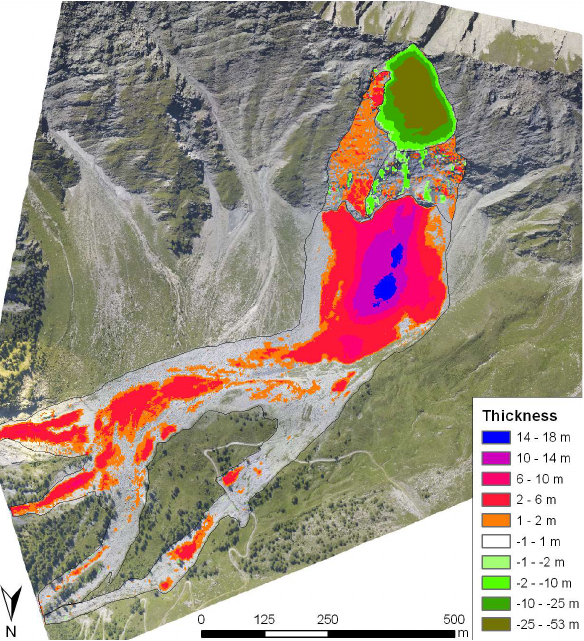
Fig. 8. Thickness map of the detachment and accumulation zones obtained after subtraction of 2009 from 2008 LiDAR DEM; thick- ness values are in